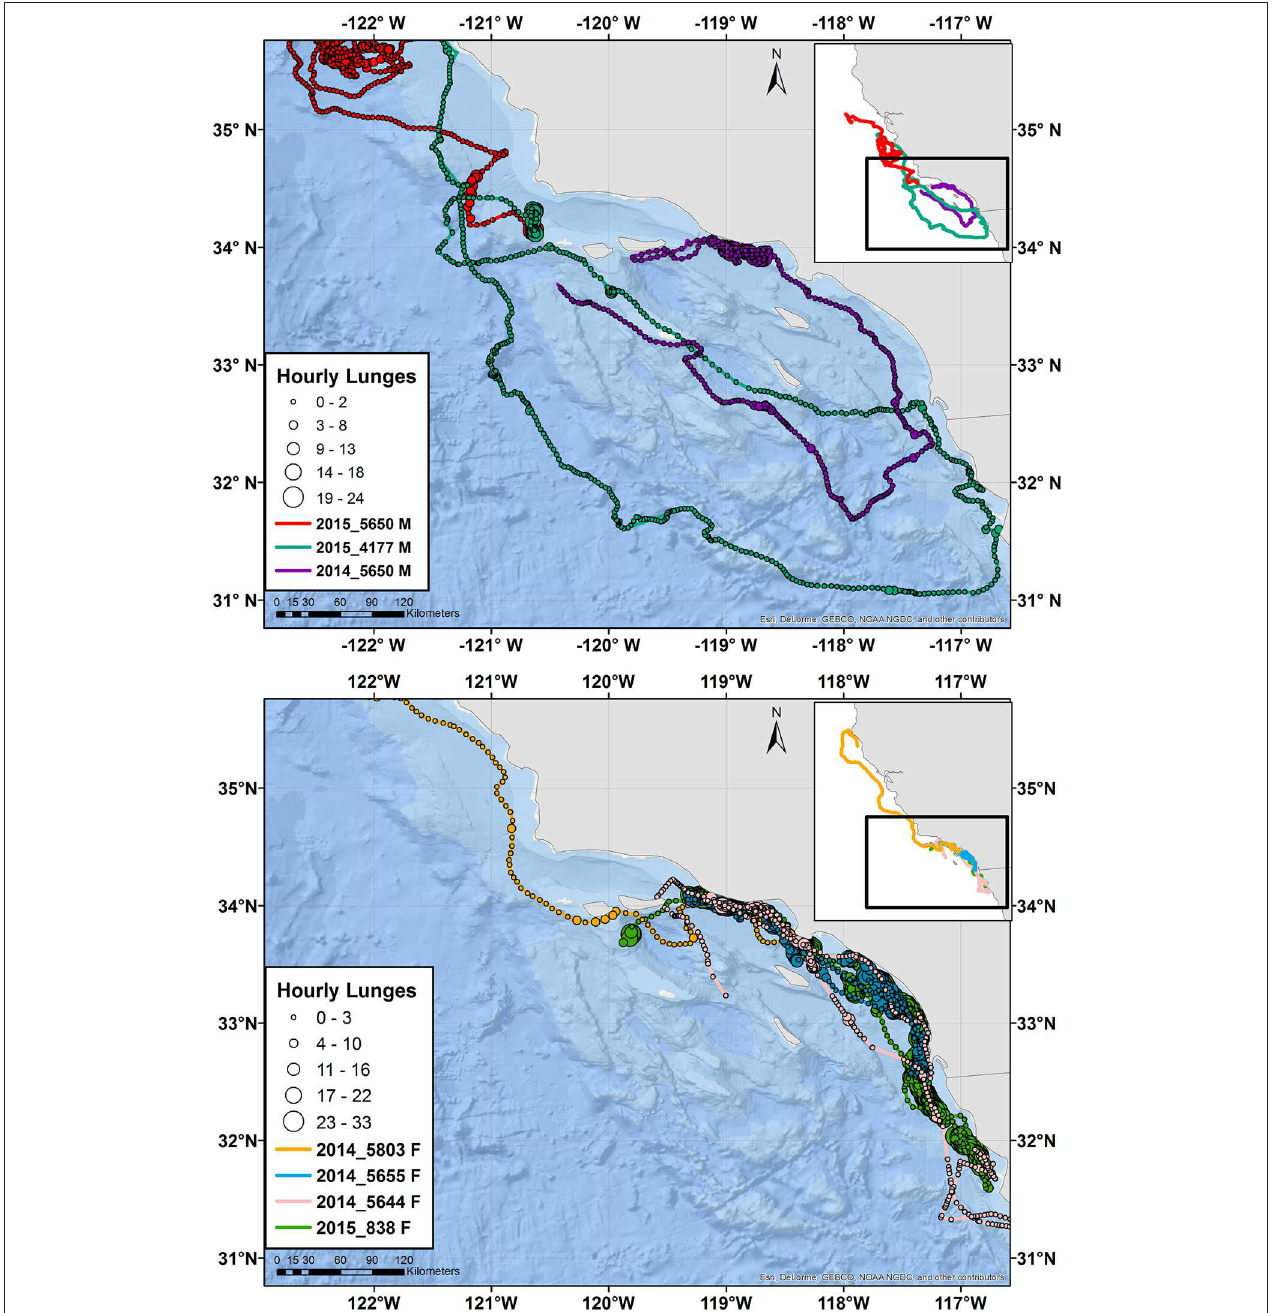
FIGURE 2 | Tracks of male (top) and female (bottom) blue whales instrumented with ADB tags in August 2014 and July 2015. Main maps zoom in on southern California, while the inset maps show the full extent of the tracks with the zoomed region identified by a black square. Circles indicate hourly average locations, with circle size scaling to number of feeding lunges per hour and circle color indicating a different individual, per the tag number shown in the key. The track for one additional blue whale of unknown sex is presented in Supplementary Figure 4 .